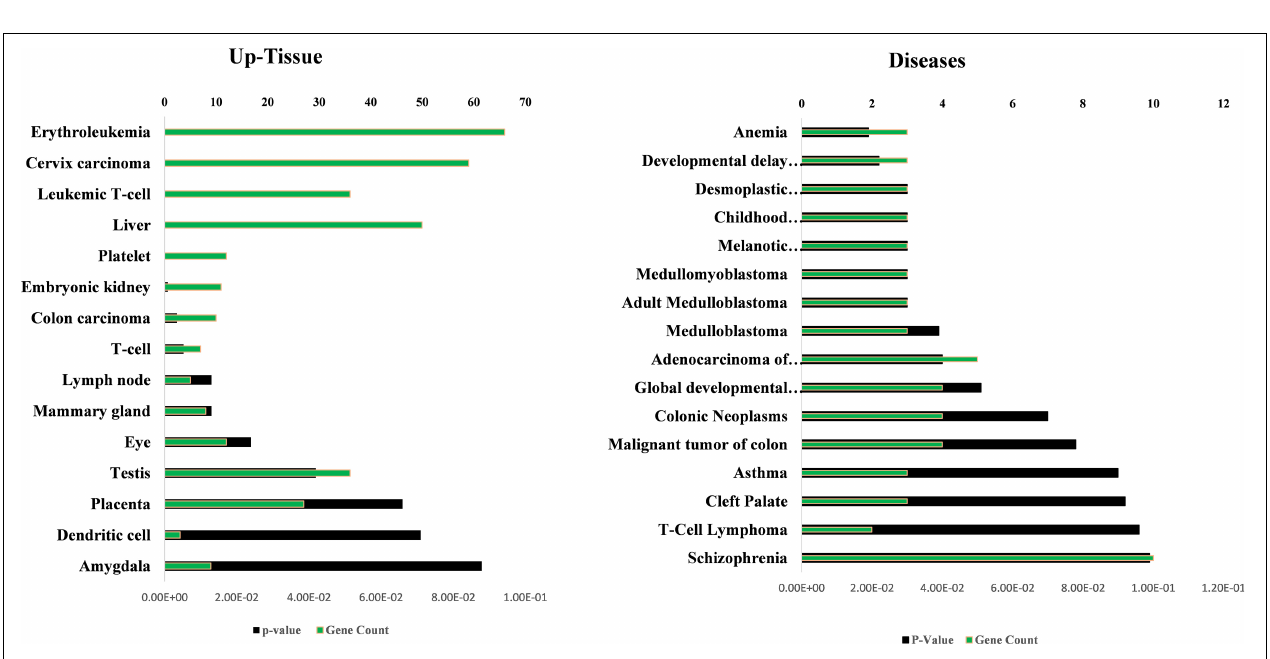
FIGURE 8 | GO annotations of upregulated DEGs among SCD, aMCI, and control groups. (A) Venn diagram showing the common upregulated DEG among SCD versus aMCI, aMCI versus control, and SCD versus control. (B) GO terms including biological process, molecular function, and cellular component of DEGs (25) from SCD versus control, also share with other SCD versus aMCI and aMCI versus control groups.